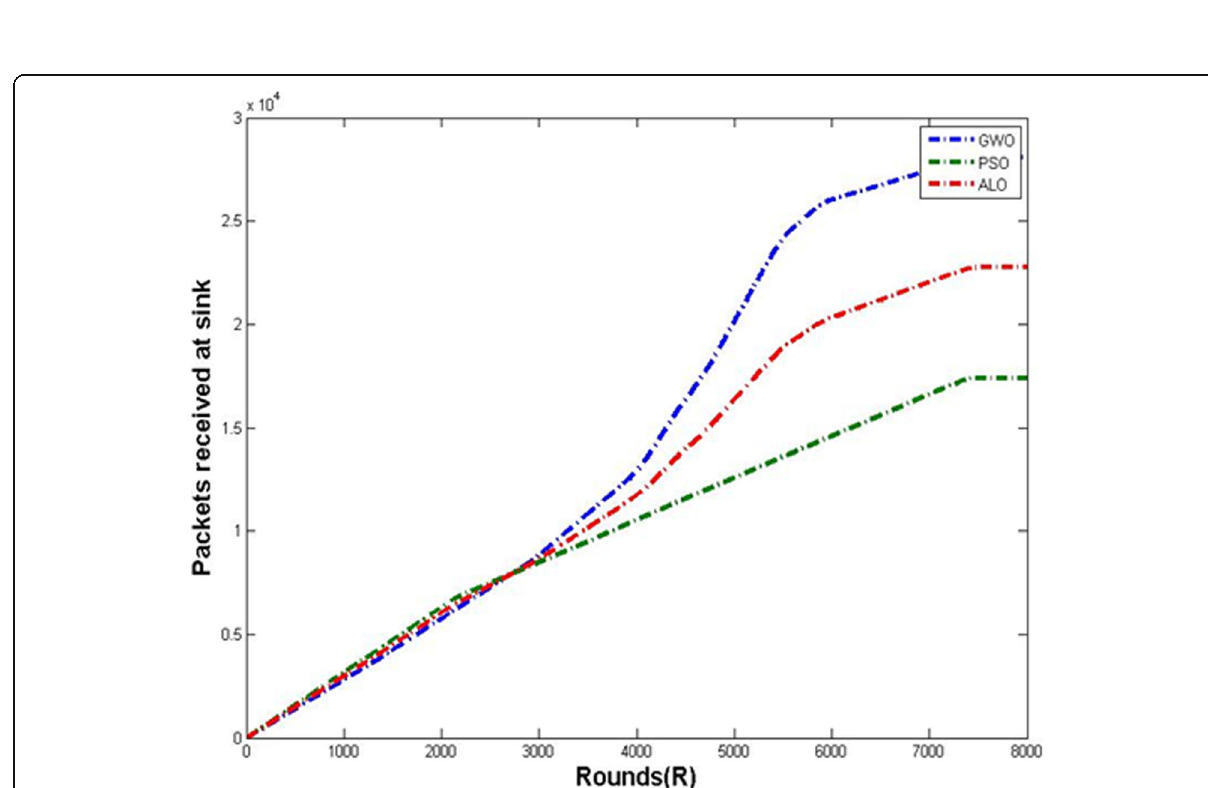
Fig. 4 Throughput for PSO, ALO, and GWO for